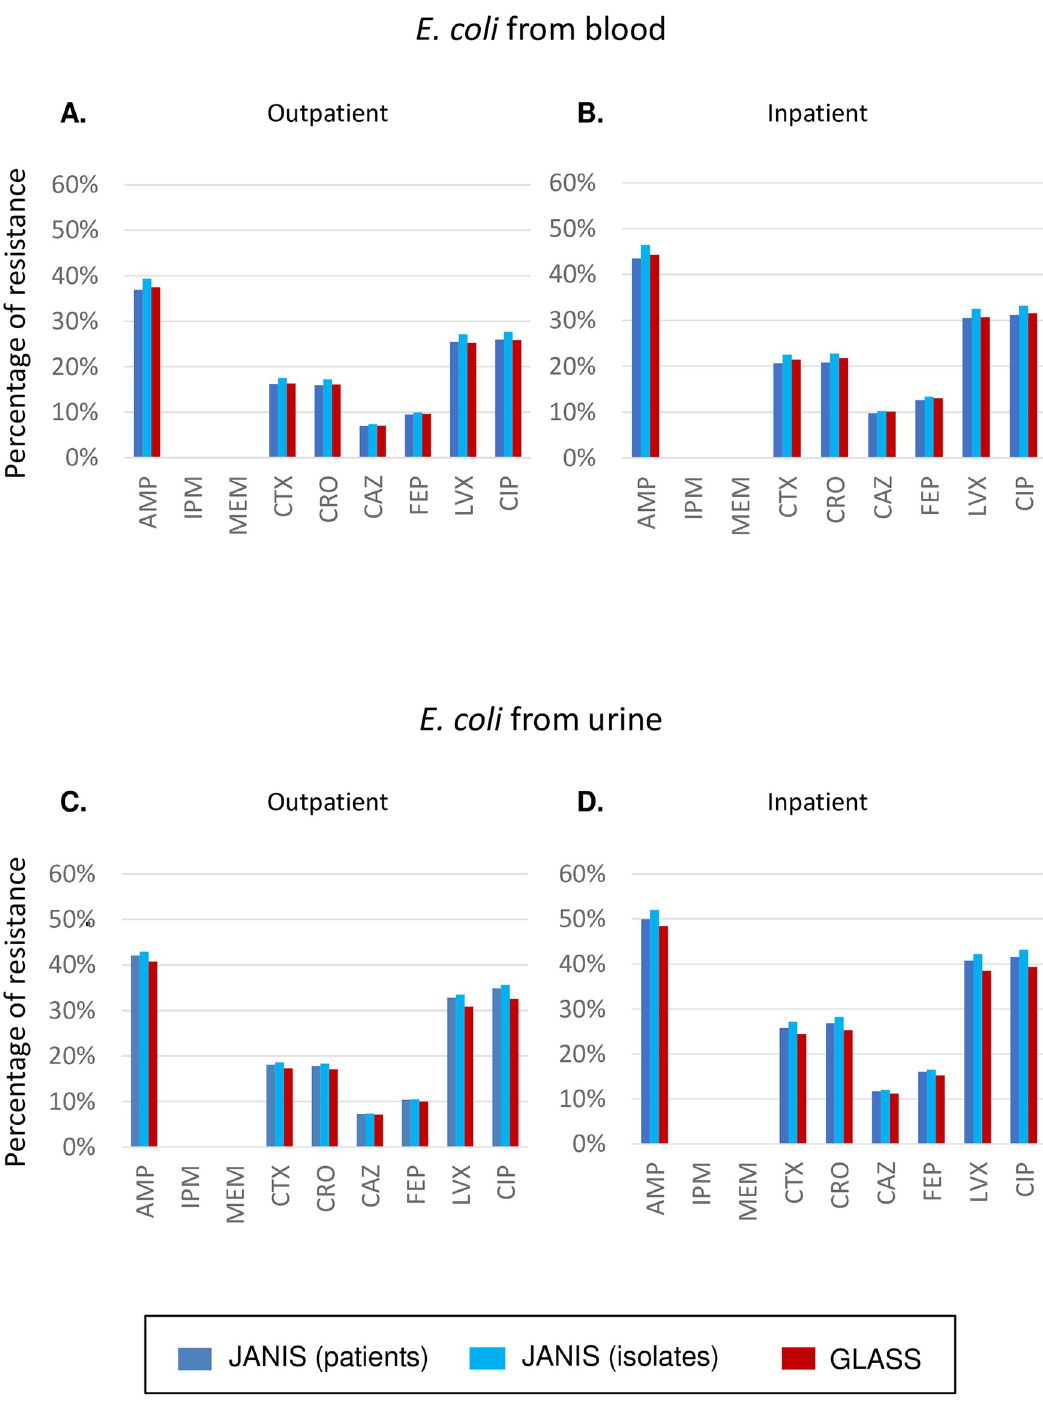
Fig 2. Comparison of percentages of resistant E . coli . Each value was calculated as the number of resistant isolates divided by the total number of isolates tested for an antimicrobial drug in the RIS file required for submission to GLASS, and is shown separately for outpatient (left) and inpatient (right). The blue and light blue bars indicate the number of patients and isolates tabulated using the de-duplication method from JANIS (see Materials and methods for detail). The dark red bars indicate the number of patients (that have 1-to-1 correspondence to the isolates) using the de-duplication method from GLASS. (A-B) Blood. The denominator for each antibiotic is always > 80,000 in outpatient and > 60,000 in inpatient settings, respectively. (C-D) Urine. The denominator for each antibiotic is always > 10,000 in both outpatient and inpatient